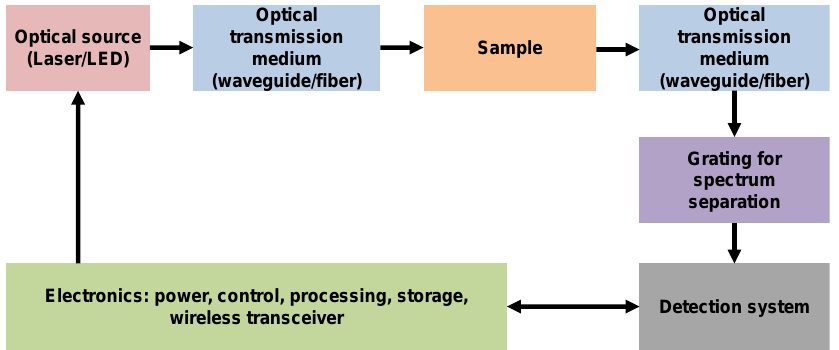
Figure 4. Schematic of an optical sensing microsystem using a Si-based platform. The sample could be a fluidic system with biological species, a chamber with gas, or a solution with target